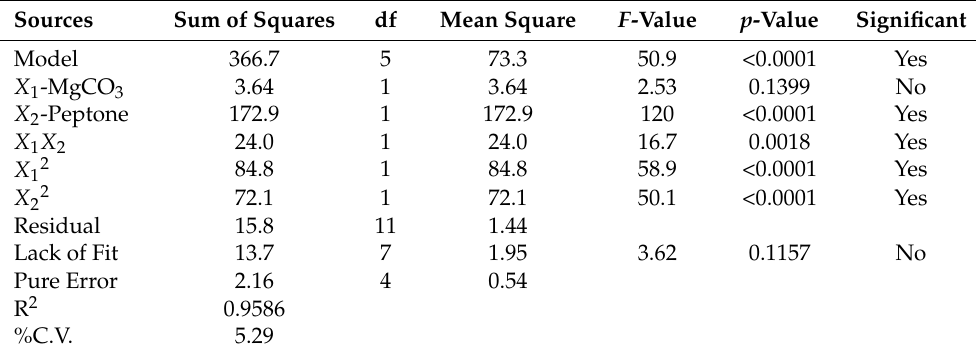
Table 6. ANOVA analysis for succinic acid production by E. gallinarum using BBD. Sources Sum of